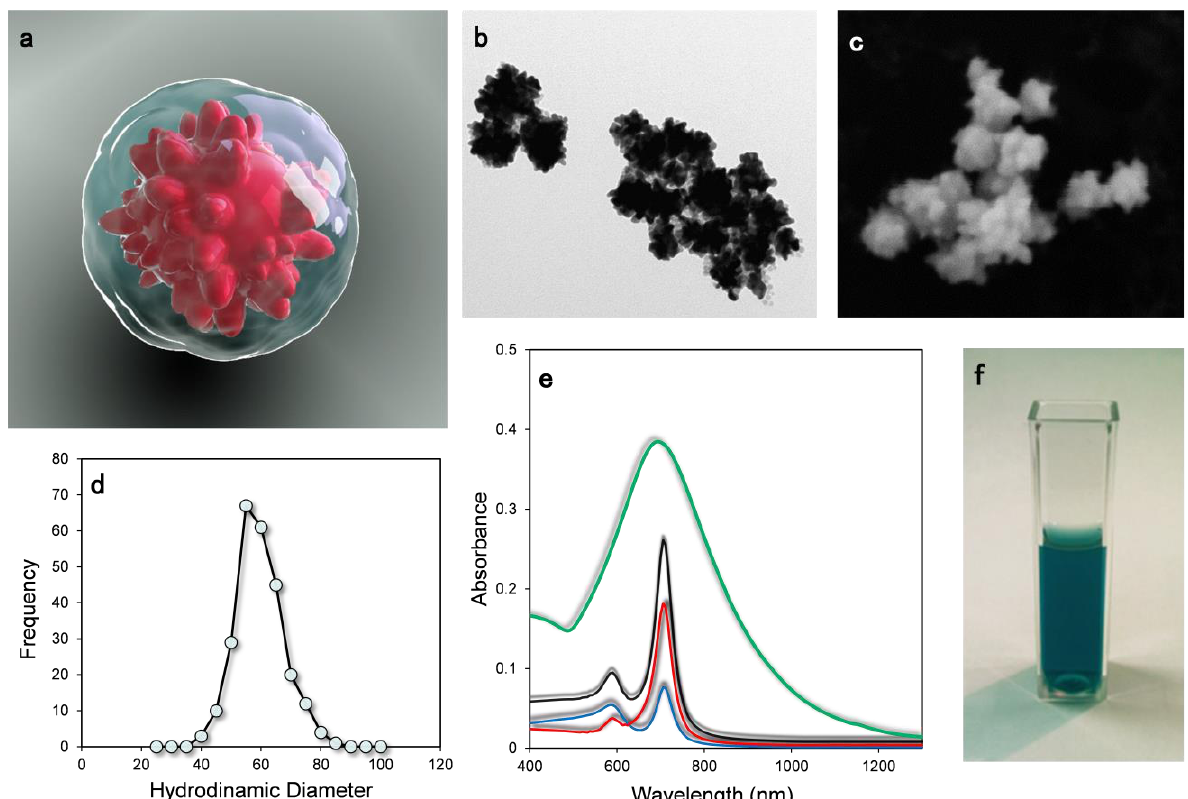
Figure 1. ( a ) 3D representation of a gold nanostar functionalized with doxorubicin molecules and coated thiol-PEG. ( b ) TEM and ( c ) SEM images of 60 nm gold nanostars. ( d ) Gold nanostars size distribution obtained by Dynamic Light scattering Scattering analysis. ( e ) UV–VIS absorption spectroscopy (green continuous line), simulation of total extinction spectrum (black line) of AuNS. The contribution of the calculated absorption (blue line) and scattering (red line) were also plotted. ( f ) Photograph of AuNS water suspension.